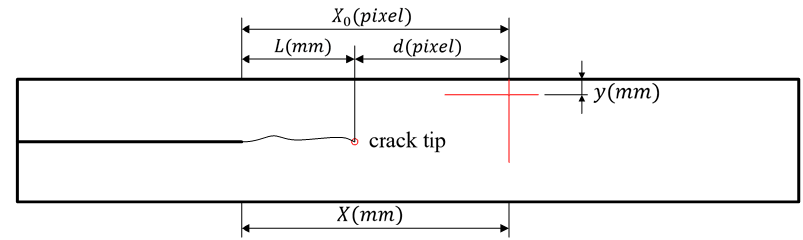
Figure 6. Relevant calculation dimensions of crack propagation length.